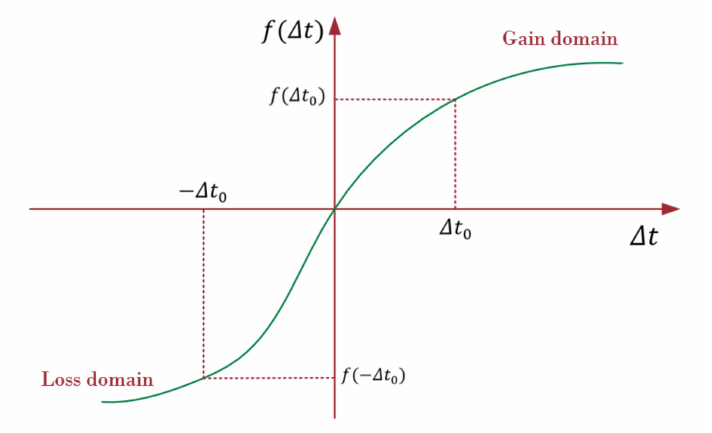
Figure 2. The prospect value